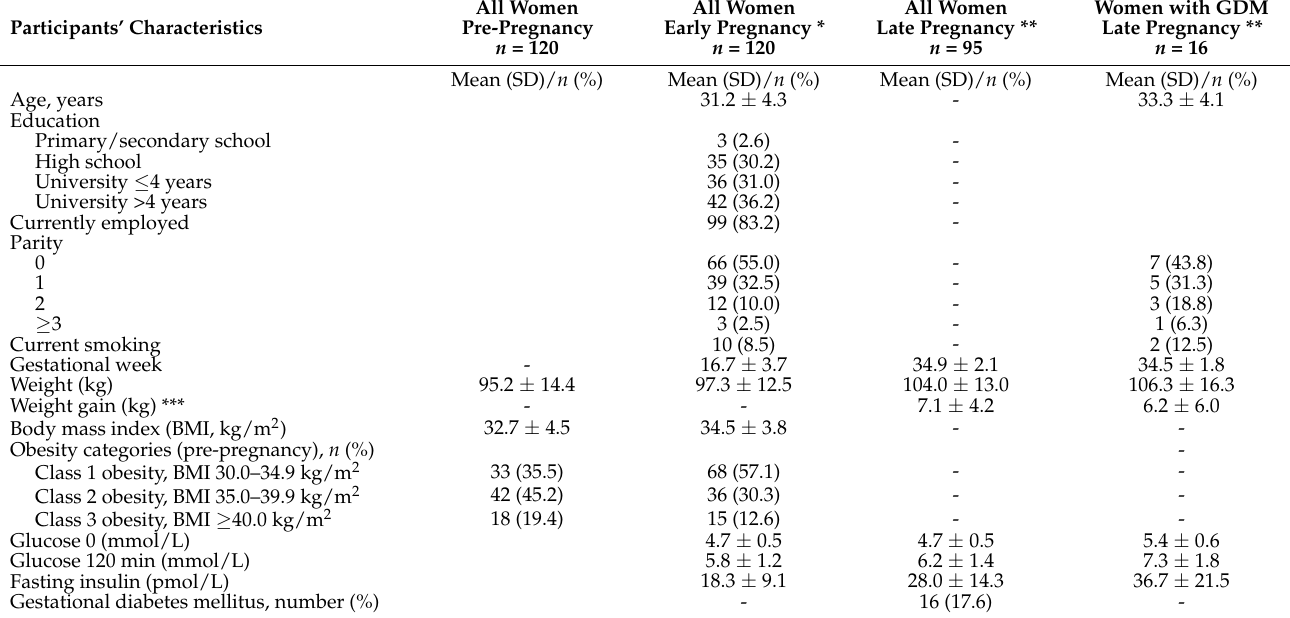
Figure 1. Flow chart of the participants included in the study. Table 1 shows the characteristics of the participants, early and late pregnancy blood glucose levels, and late pregnancy prevalence of GDM. Of our study population, 48% were allocated to the exercise intervention group in the respective trials. Sixteen partici- pants developed GDM. Table 1. Characteristics in early and late pregnancy of participants with pre-pregnancy obesity. Ob- served data are presented as mean and standard deviation (SD) or number of participants ( n ) and percentages (%).